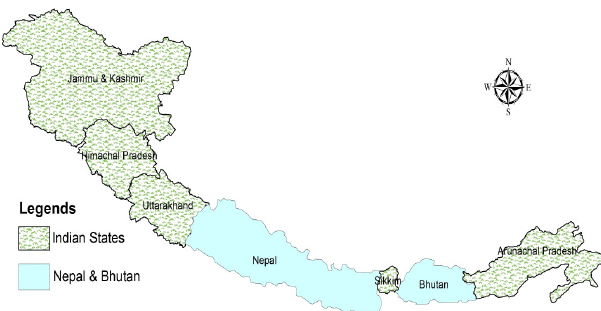
Fig. 2. Distribution of Allium wallichii and A. strachey in the Himalayan